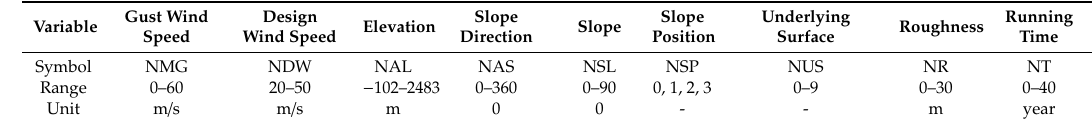
Table 1. Value range of each